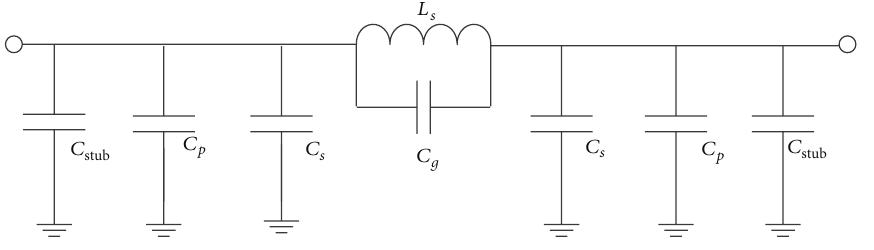
Figure 3: Equivalent 𝜋 -circuit model of the proposed structure.